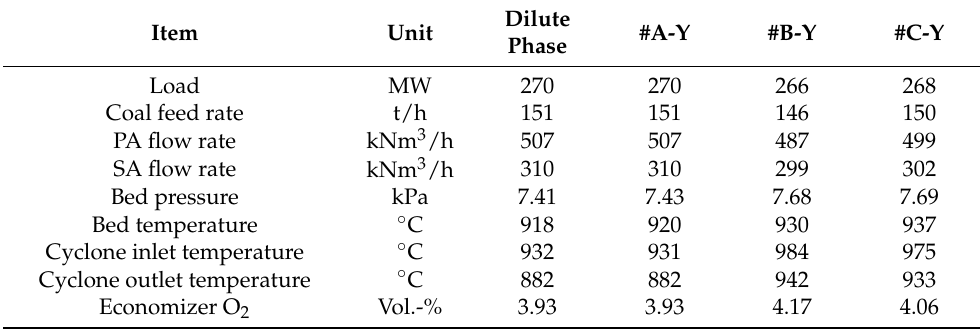
Table 3. Main operating parameters of the boiler during the tests of the dilute phase and the vertical